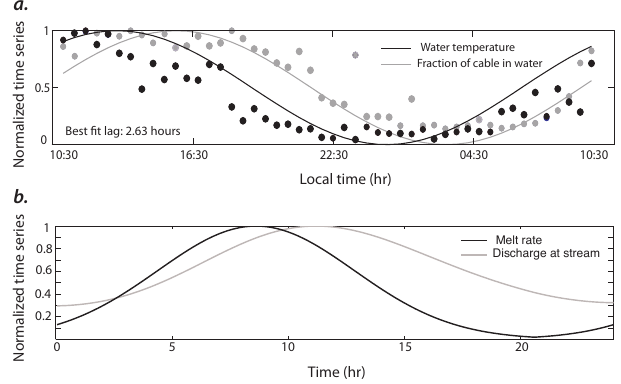
Fig. 6. (a) Lag between normalized time series of DTS tempera- ture and fraction of cable in water (Fig. 5) with nonlinear fits of daily-periodic sinusoids. (b) Modeled time lag between discharge at channel outlet and melt input (assumed constant over the domain). Length of recharge is B = 10m, all other parameters as in Fig.